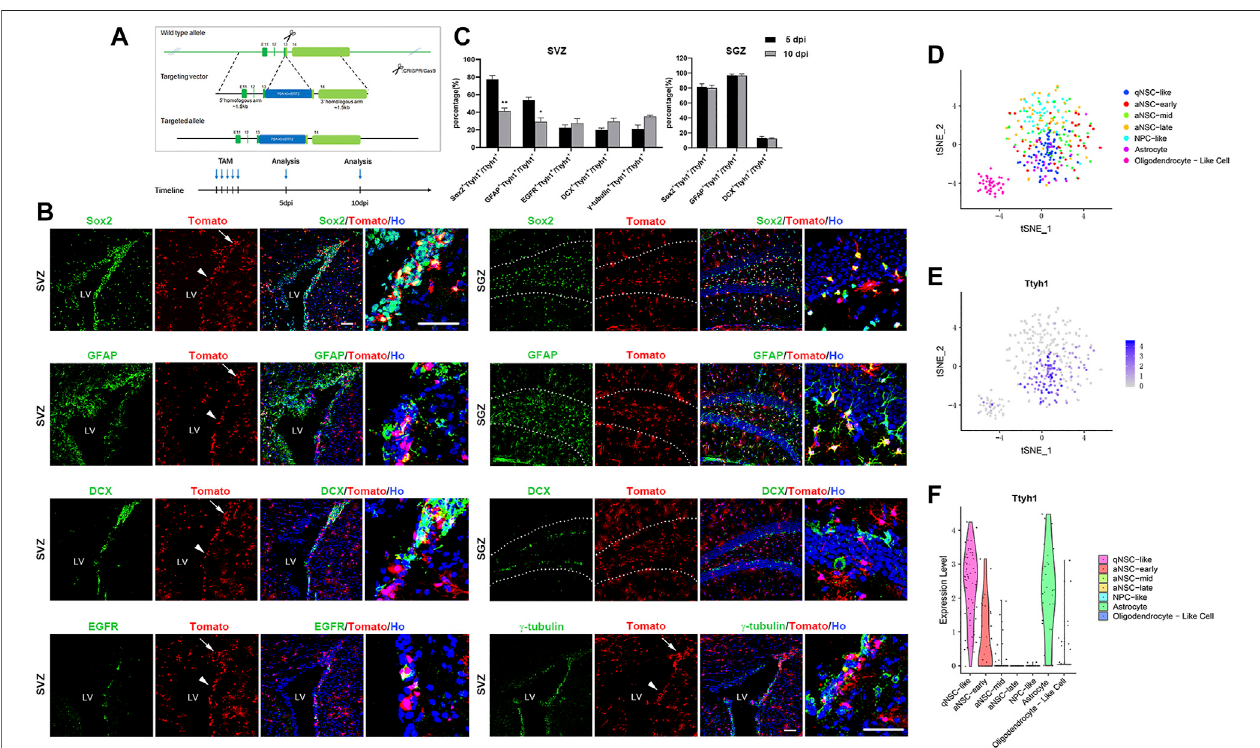
FIGURE 2 | Ttyh1 is mainly distributed in qNSCs and astrocytes in neurogenic niche. (A) Diagrams of Ttyh1-CreERT2 mice construction and tamoxifen induction strategy.TargetingvectorintroducedP2A-iCreERT2intothe13thexonlocatedatthe3 ’ terminalof Ttyh1 genetoconstructTtyh1-CreERT2mice,withTtyh1ORFintact. After crossing with Ai9 Rosa26-tdTomato reporter mice, Ttyh1-CreERT2; Rosa-tdTomato mice were obtained and were injected tamoxifen for continuous 5 days at 8 weeks old. Samples were taken at 5 days post induction (dpi) and 10 dpi for analysis. (B) Immuno fl uorescence analysis of reporter mice in neurogenic niches. The samples taken from 5 dpi group showed that Ttyh1-tomato + cells in SVZ were mainly concentrated on the striatal side (arrowheads) and dorsal wedge (arrows). These Ttyh1-tomato + cells mainly co-labeled with Sox2 and GFAP, and less co-labeled with DCX in SVZ and SGZ. Ttyh1-tomato + cells also co-labeled with EGFR and γ -tubulin atasmallproportion inSVZ. (C) Statisticsoftheproportions ofco-labeledcellsinTtyh1-tomato + cells.Theproportions ofSox2 + Ttyh1 + cellsandGFAP + Ttyh1 + cells were signi fi cantly reduced at 10 dpi compared with those at 5 dpi. (D) Single-cell cluster analysis of single-cell RNA sequencing data showed the classi fi cation of adultNSCsinSVZandtheirprogenycells. (E) TheparallelanalysisofDshowedthedistributionofTtyh1transcriptsincellclusters.PurpledotsrepresentTtyh1 + cells. (F) Violin plot of Ttyh1 distribution in NSCs and progeny cells based on single-cell RNA sequencing data. Ttyh1 was highly expressed in qNSCs and astrocytes (in accordance with accumulated Tomato + cells in SVZ, and scattered Tomato + cells outside SVZ in B, respectively). Scale bar (cid:2) 50 μ m in B. n (cid:2) 3for all experiments. Data are expressed as mean ± SEM. Statistical signi fi cance was calculated using an unpaired, two-tailed Student ’ s t -test. ( pp ) p < 0.01, ( p ) p < 0.05. LV, lateral ventricle.